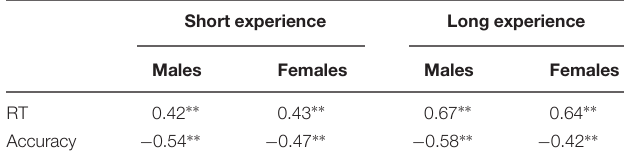
TABLE 1 | Correlation between mean RTs, accuracy and interpair distance